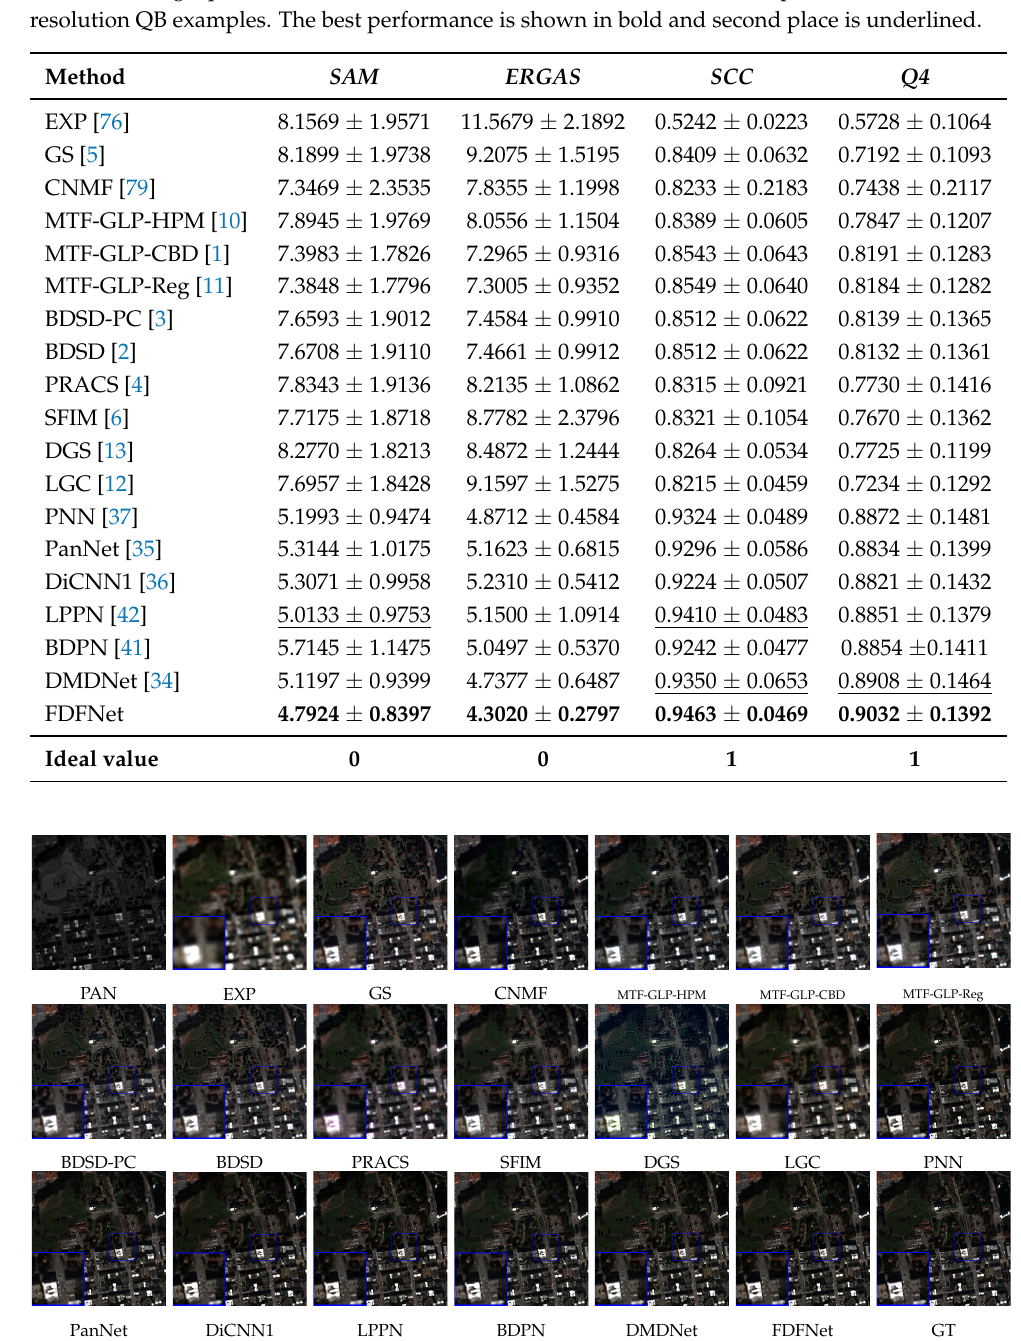
Figure 7. The visual comparisons of fusion results obtained by different methods on a reduced- resolution QB case (shown by bands: 1, 3, and